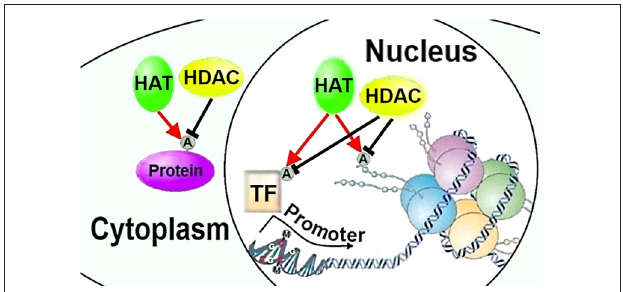
FIGURE 1 | HATs and HDACs can regulate neurite growth through chromatin remodeling or post-translational modifications of transcription factors and cytoplasmic proteins. HAT, histone acetylase; HDAC, histone deacetylase; A, acetylation; TF, transcription factor (Figures 1–3 adapted in part from Levenson and Sweatt